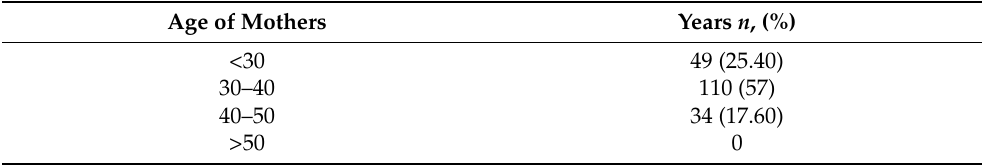
Table 1. Age of mothers who completed the